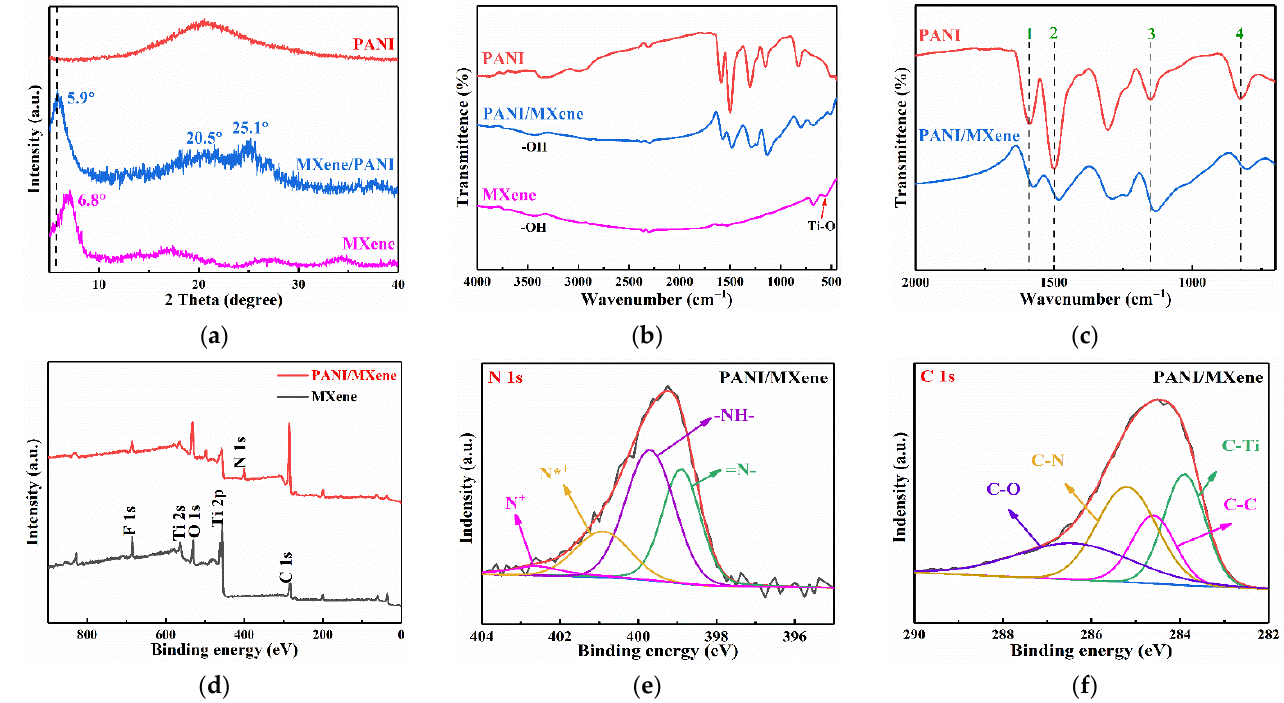
Figure 4. ( a ) XRD patterns of MXene, PANI and PANI/MXene; ( b ) FT–IR spectra of MXene, PANI, and PANI/MXene; ( c ) FT–IR spectra of PANI/MXene with a wavenumber at 2000 to 700 cm − 1 . Lines 1 and 2 represent the redshifts of the absorp- tion bands of quinone ring and the benzene ring, respectively. Lines 3 and 4 represent the redshifts of the C-H bending vibration absorption bands. ( d ) XPS analysis of pure MXene and PANI/MXene; ( e ) N 1s and ( f ) C 1s high-resolution spectra scans of PANI/MXene.